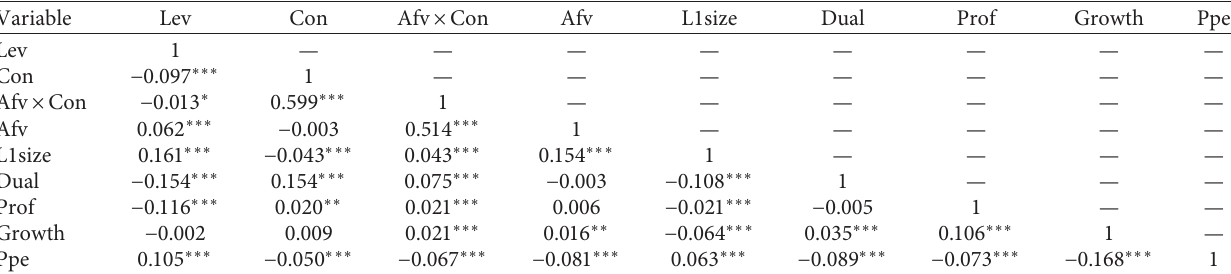
Table 2: Pearson coefficient test.